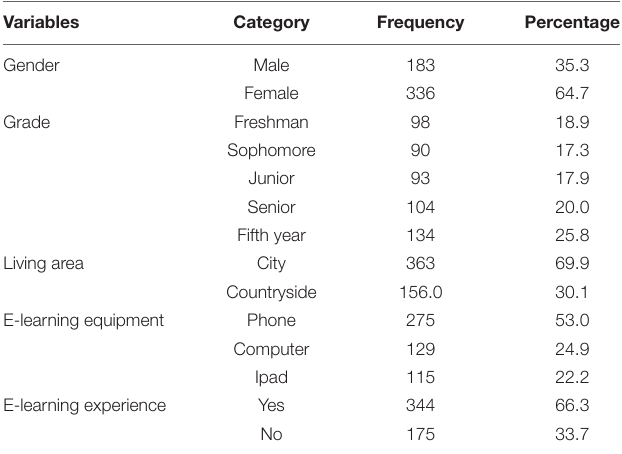
TABLE 1 | Demographic characteristics of respondents ( n =